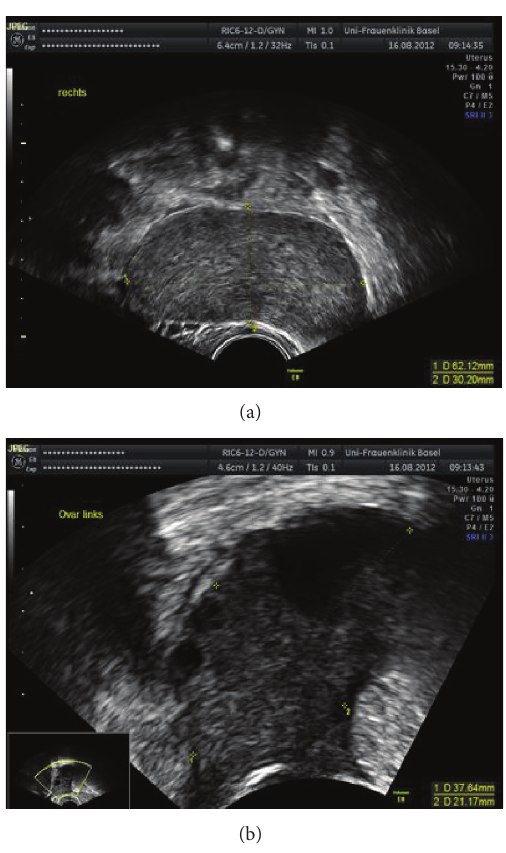
Figure 4: Ovarian ultrasound after 1st cycle of